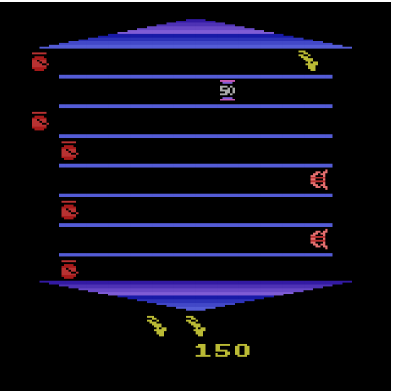
Figure 8. Atari game Asterix, in which dueling Q–network outperformed the double DQN by 1097%. Image taken using the OpenAI Gym Python package